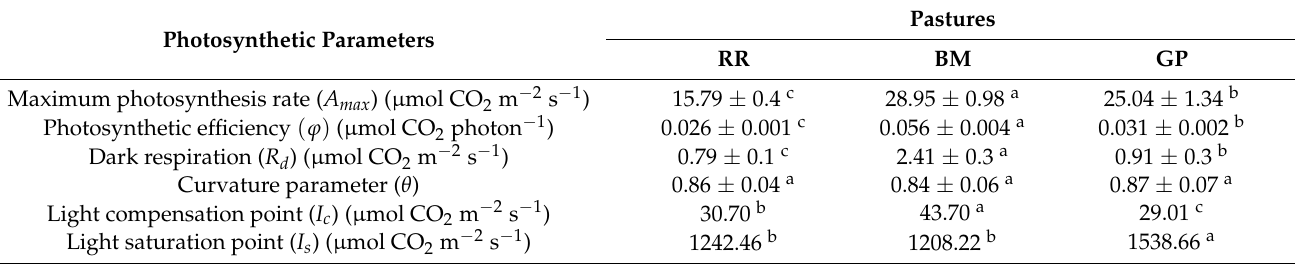
Table 1. Pasture species effects of photosynthetic light response parameters of tropical pastures (means of four plots) measured on 11 February 2021 at Gatton Research Dairy, Queensland,